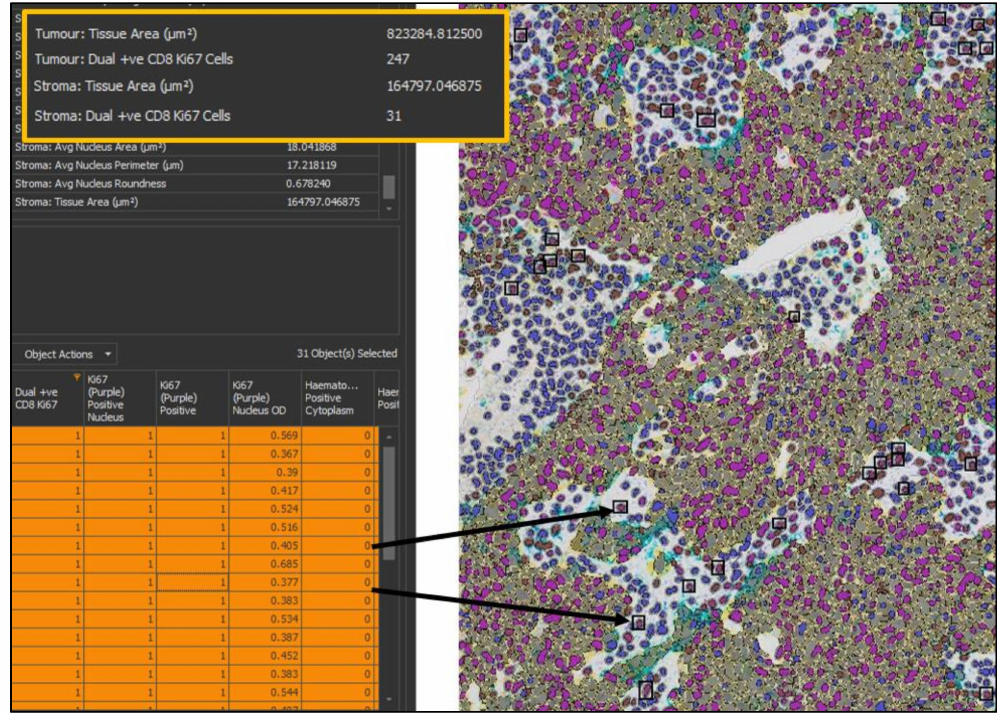
Figure 7. Results of a multiplexed immunohistochemistry (mIHC) analysis in HALO. The top left table provides the summary results from the analysis; important outputs in this analysis are the density of cells co-expressing both CD8 and Ki67 in the tumor and stroma, and so the data relating to this has been highlighted. The bottom left table is HALO’s interactive cell-by-cell data table, which can be mined to find specific cell types. Here, only cells that are positive for CD8 and Ki67 and are in the stroma have been selected. HALO will find the cells selected in the image viewer (right, 20 × magnification) by putting a black box around each